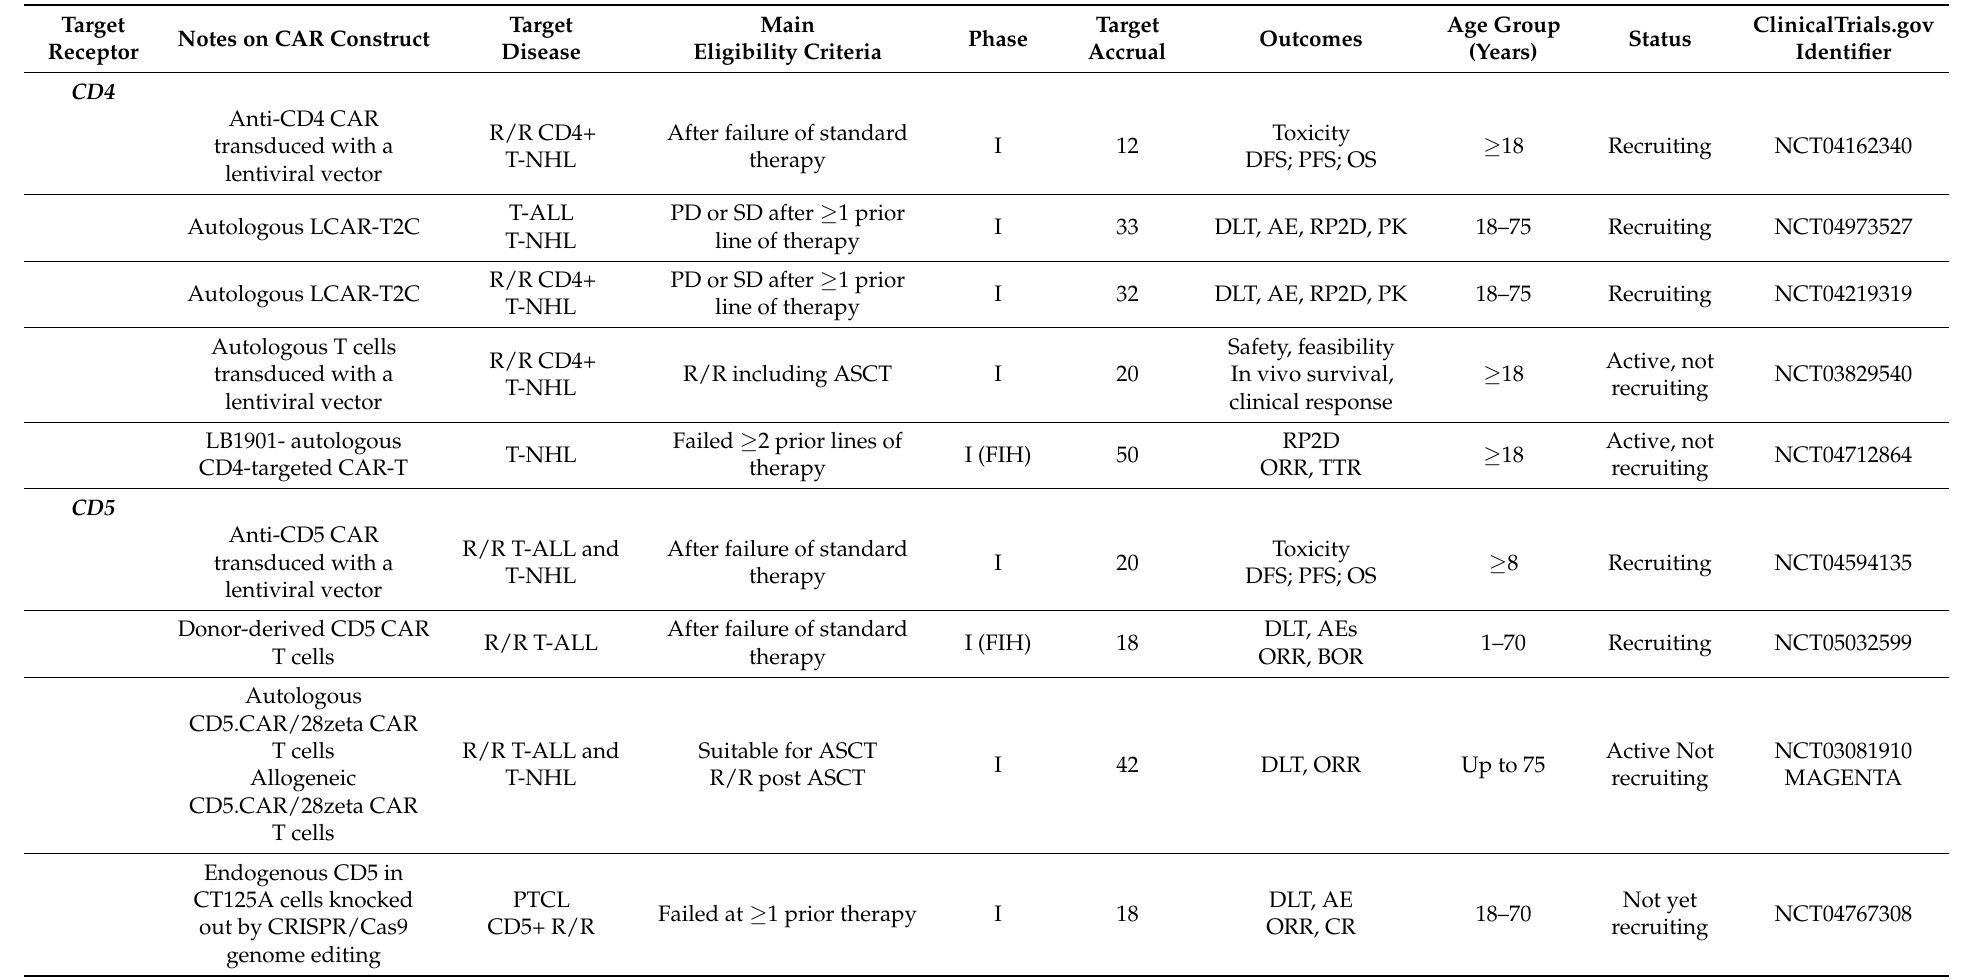
Table 1. Available target antigens with their corresponding ongoing clinical trials for CAR-T therapy of T-cell